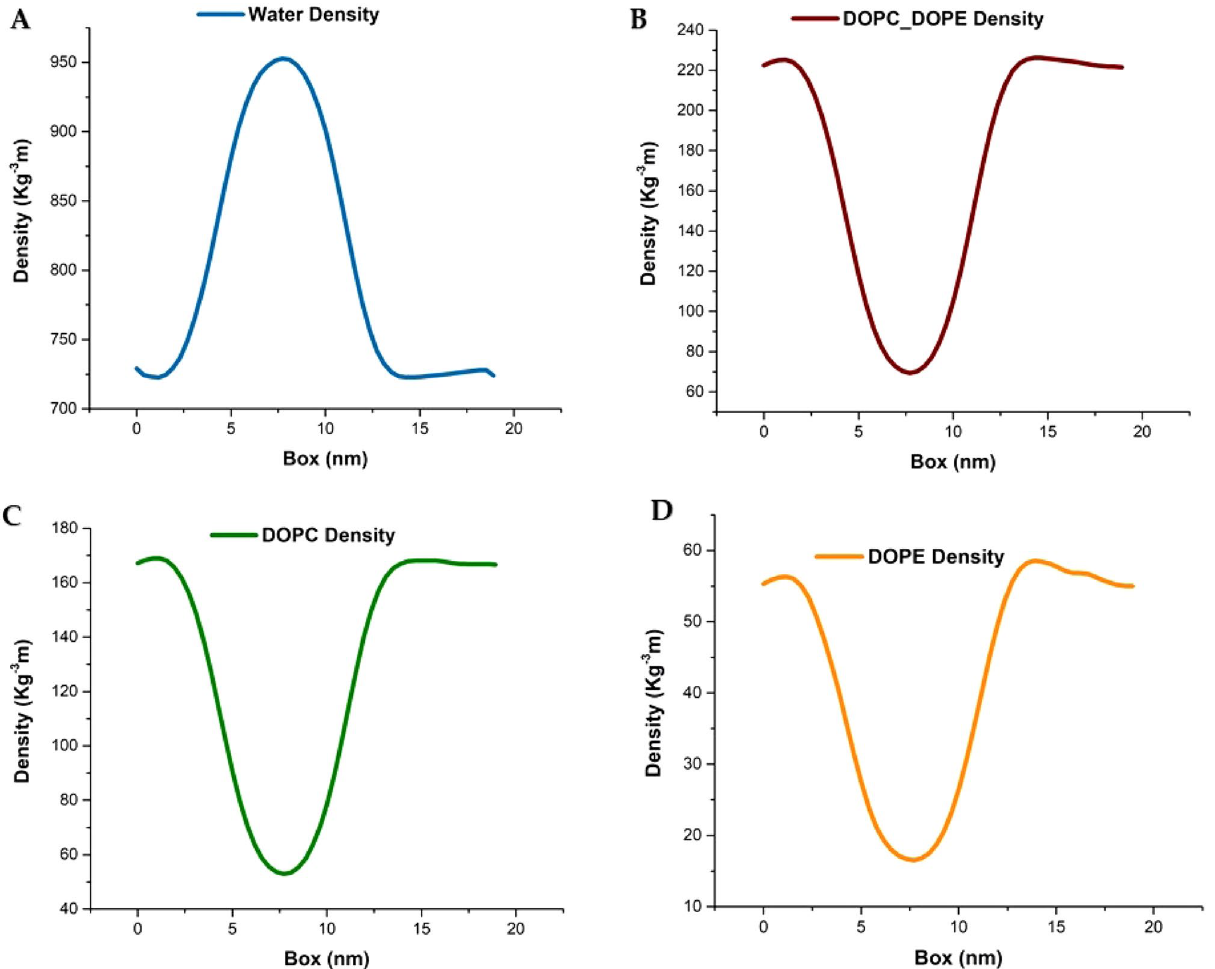
Figure 7. The density profile of the water, DOPC–DOPE, DOPC, and DOPE molecules of the liposome model structure along the simulation box is shown. The density maxima of the water were in the middle of the box (7.5 nm) and the density maxima of the lipids in the margin of the box. These densities confirm that the liposome model structure was